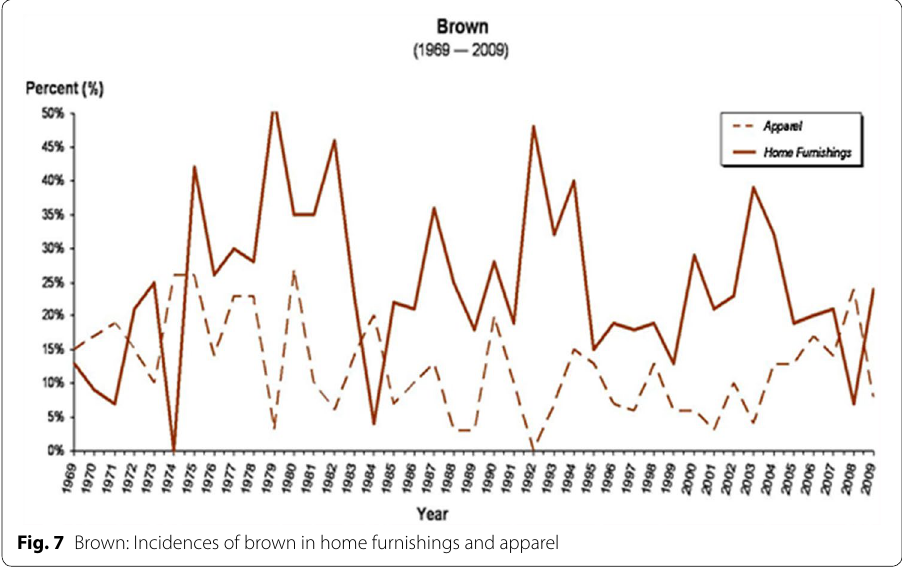
Fig. 7 Brown: Incidences of brown in home furnishings and apparel